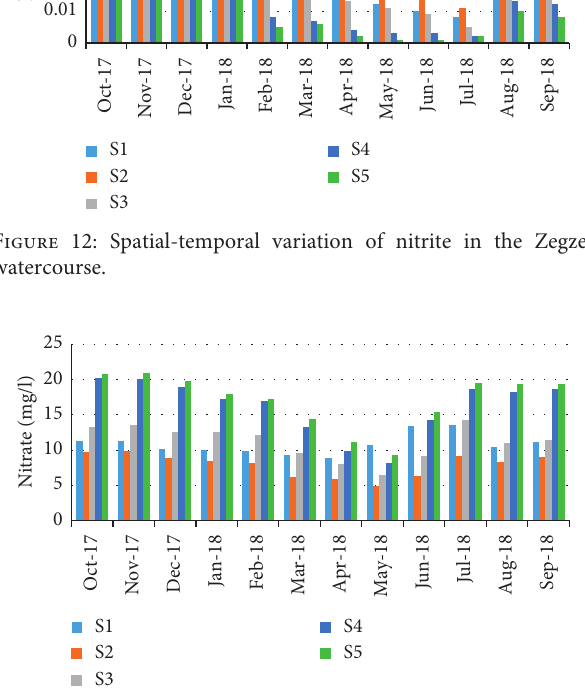
Figure 13: Spatial-temporal variation of nitrate in the Zegzel